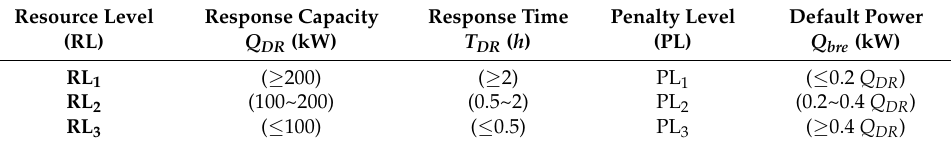
Table 1. The classification of different grades for response